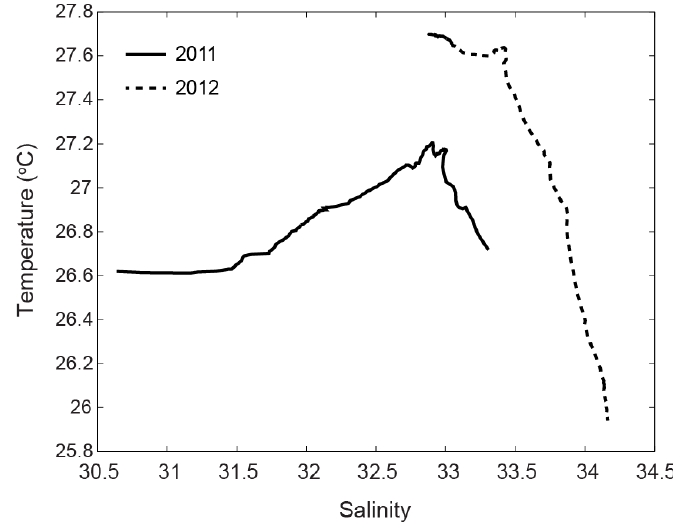
Figure 8. Temperature-salinity plot for mean of cast 2 along the transect in 2011 (solid black) and 2012 (dashed